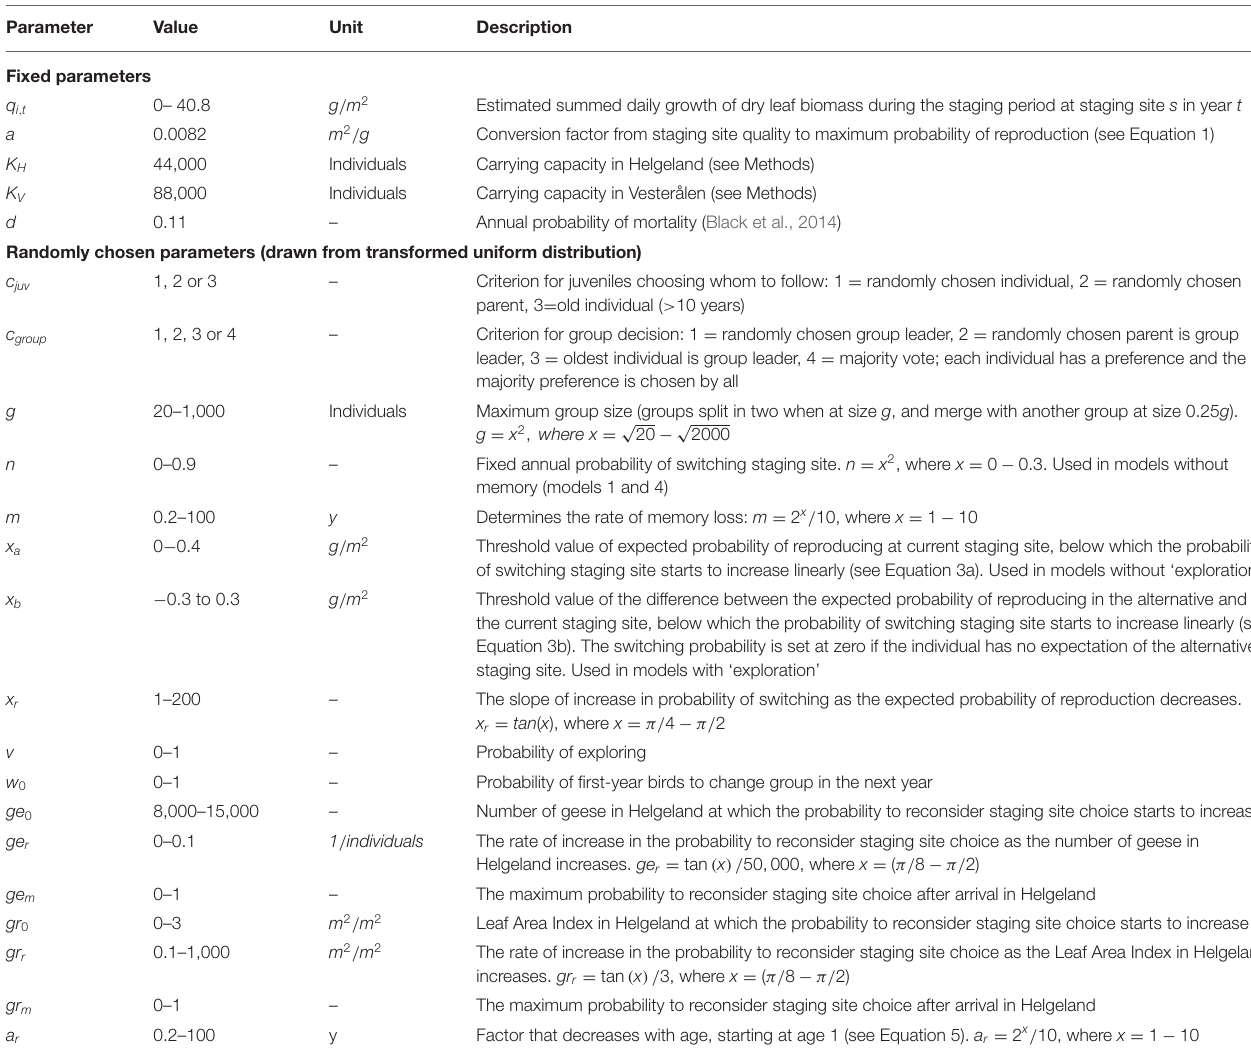
TABLE 1 | Parameter values used in the simulation runs.